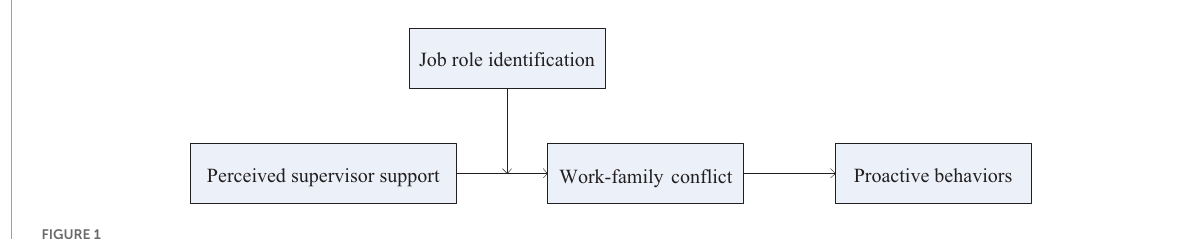
FIGURE1 Theoretical model. SS, Perceived supervisor support; WFC, work-family conflict; JRI, job role identification.